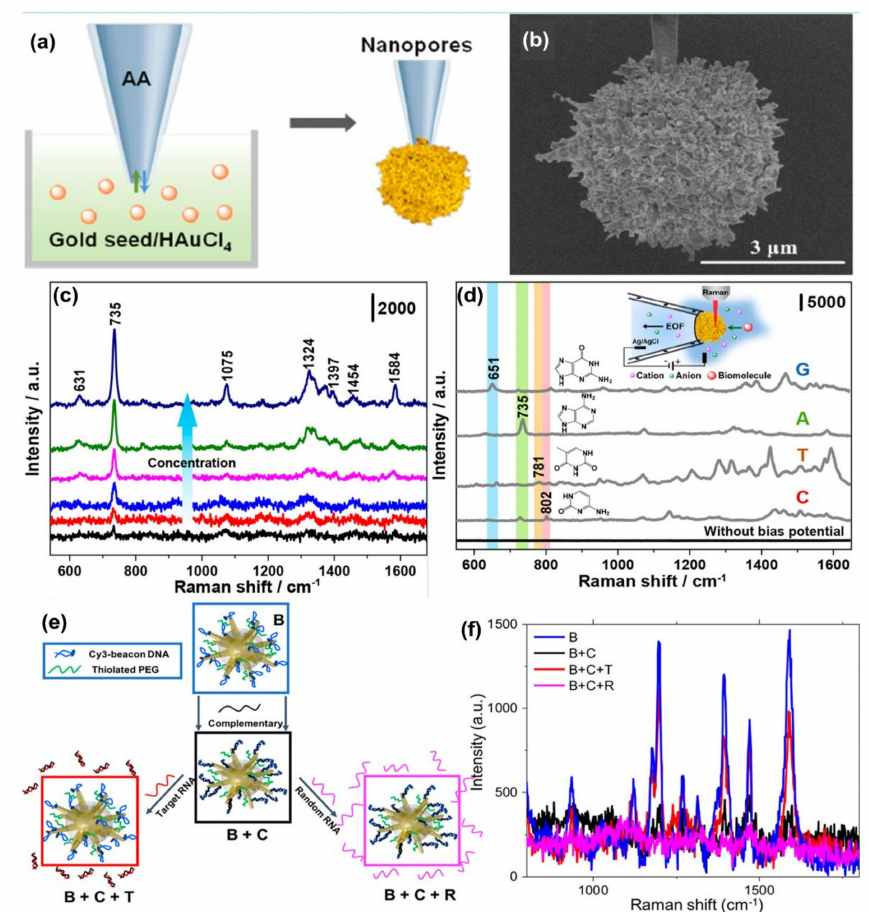
Figure 5. Panel ( a ) is the schematic of the synthesis of plasmonic nanopores process. SEM image of the gold plasmonic nanopores is shown in panel ( b ). Panel ( c ) represents SERS spectra of A translocating through gold plasmonic nanopores with a bias potential of − 1 V, from low to high 10 − 9 to 10 − 4 M, respectively. Panel ( d ) represents the SERS-based nonresonant molecules detection of the four nucleobases (G, A, T, and C). The scheme of measurement setup (inset). Reprinted (adapted) with permission from ref. [106], Copyright 2019 American Chemical Society. Panel ( e ) shows the Au nanostars are functionalized with a Cy3-tagged beacon DNA, creating the SERS-active nanostar probes (B), and then hybridized with a complementary oligonucleotide (B + C). Upon exposure to the viral RNA targets, the complementary oligonucleotide dehybridizes from the beacon and hybridizes with the viral RNA (B + C + T), returning the beacon to its original hairpin conformation and leading to SERS signal recovery (B + C + R), Panel ( f ) is the SERS signal “ON-OFF-ON” switching: ON with beacon in hairpin conformation (B); OFF when the beacon is hybridized with 500 nM complementary oligo (B + C); then ON again upon exposure of SANSPs to 500 nM target viral RNA (B + C + T); Signal recovery was not observed after a random RNA sequence (500 nM) was introduced (B + C + R). Reprinted (adapted) with permission from ref. [111], Copyright 2020 American Chemical